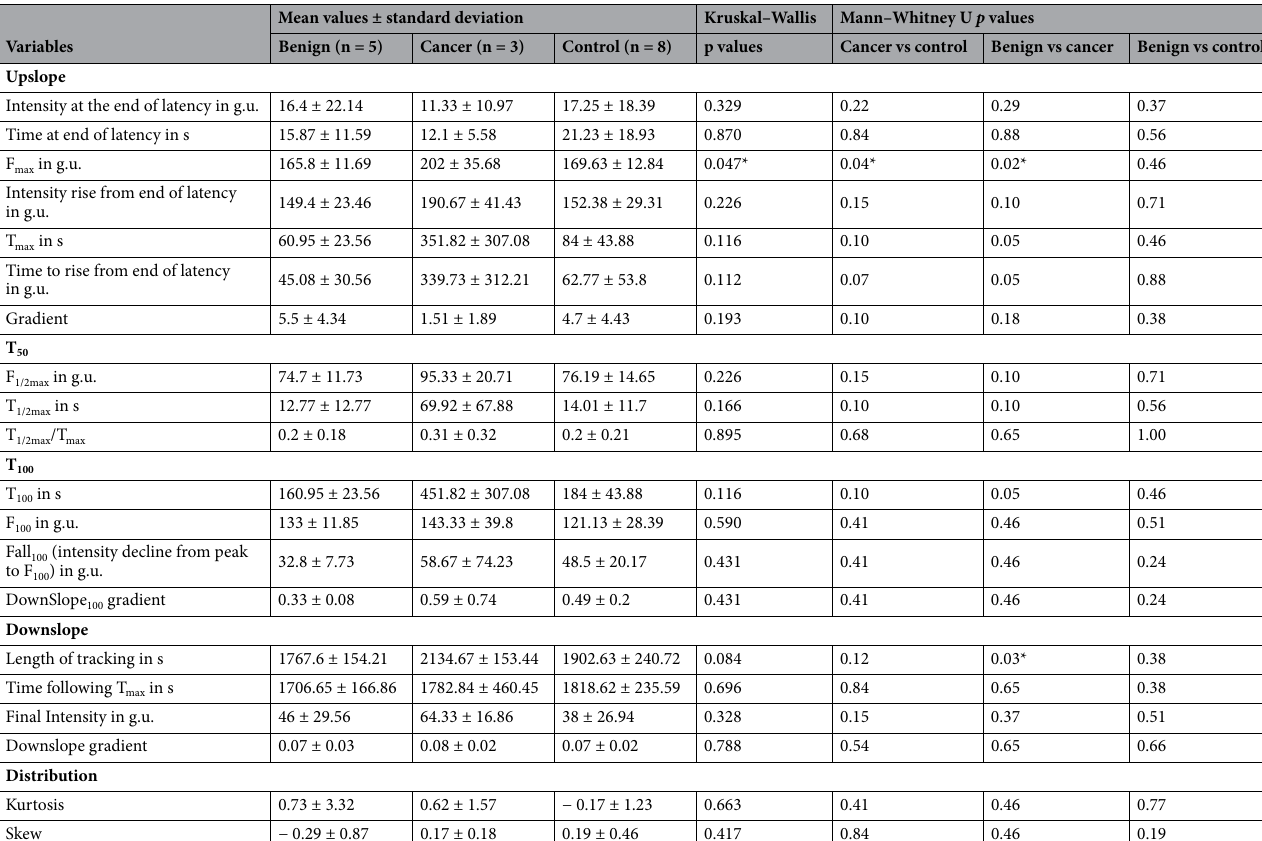
Table 2. Tabulated measures of graph parameters from manual ImageJ quantification of fluorescence intensity curves for videos of rectal lesions viewed in vivo, endoscopically under both white light and near-infrared continuously after 0.25 mg/kg ICG administration. g.u denotes grey